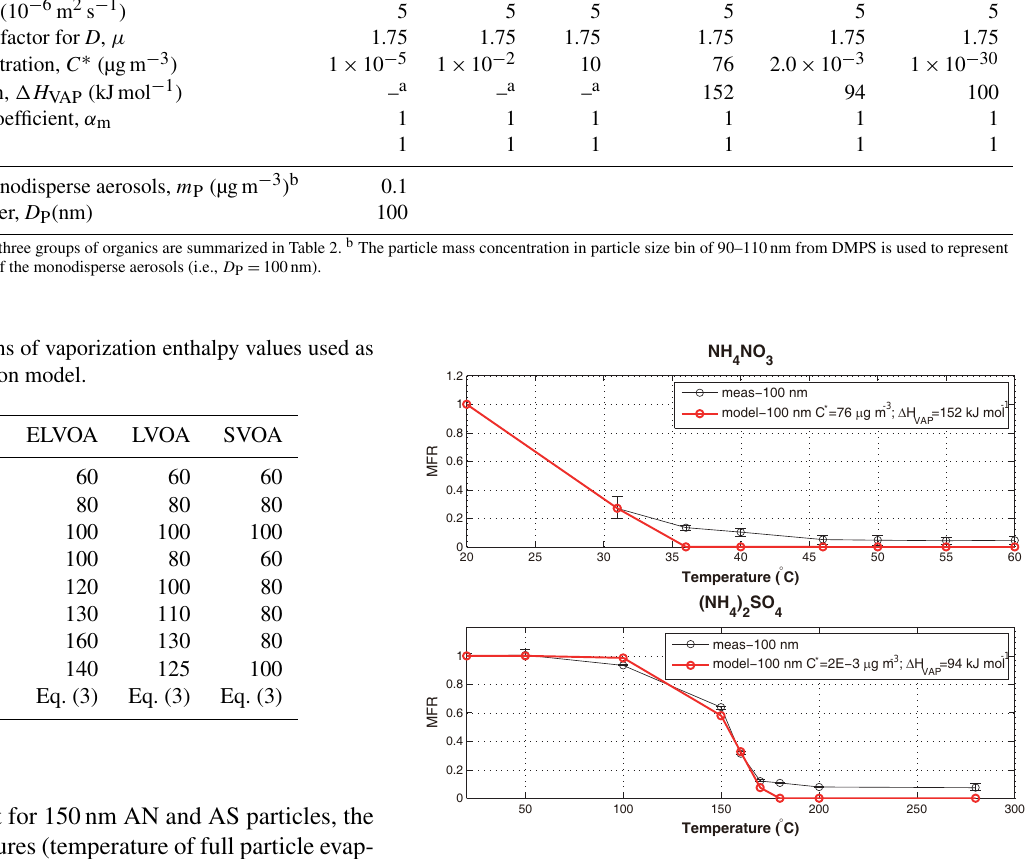
Figure 2. Thermograms of ammonium nitrate and ammonium sul- fate using the VTDMA (black lines) and the modeled evaporation using saturation vapor pressures and enthalpies of vaporization cor- responding to the best fit with the experimental data (red